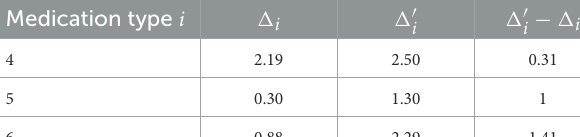
TABLE 4 Un-biased medication effects in medication type 4, 5, and 6.